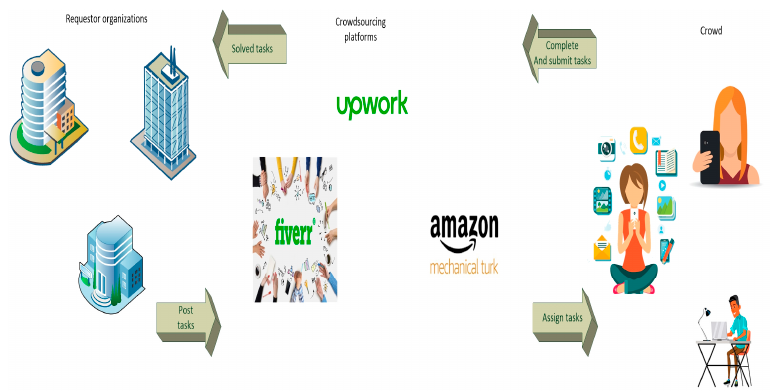
Figure 1. Crowdsourcing entities and its task assignment strategy representation .